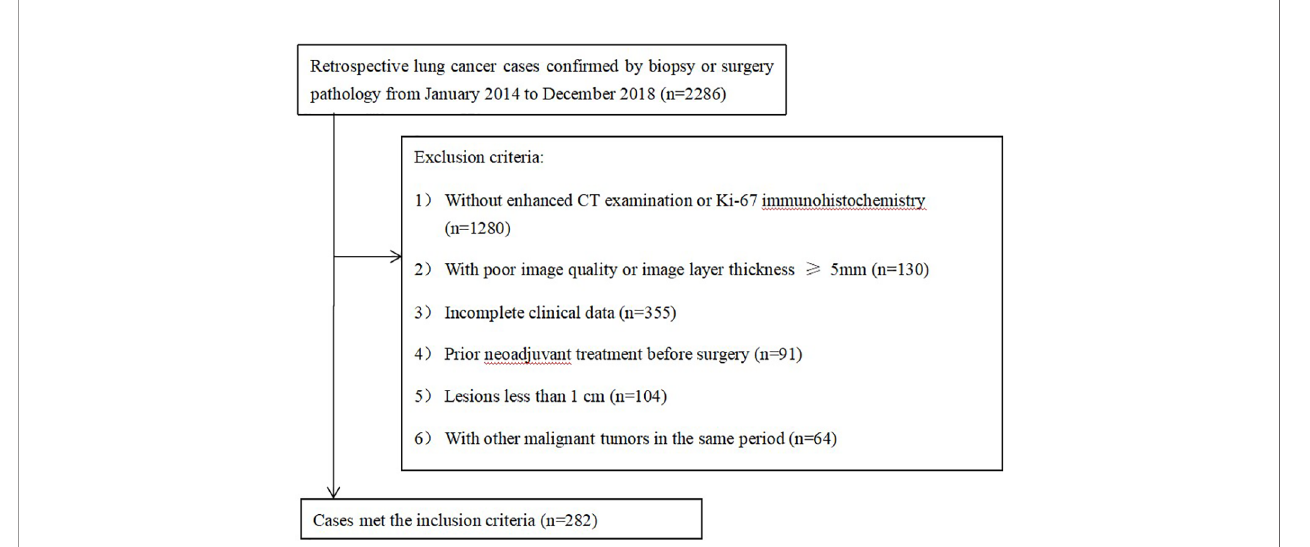
FIGURE 1 | Flow diagram of the patient